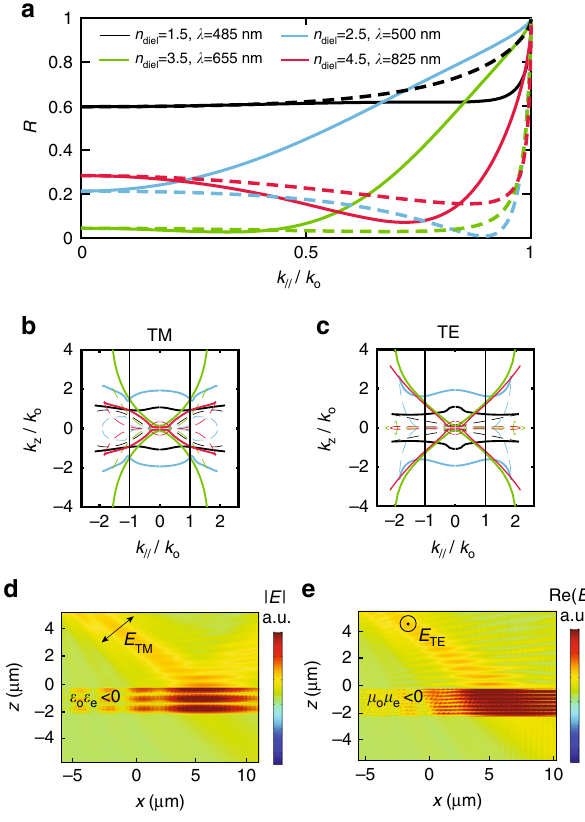
Fig. 4 Bulk propagating modes in magnetic hyperbolic layered metamaterials. Analytical calculations of a re fl ectance and b , c isofrequency diagrams for a metamaterial consisting of fi ve alternating layers of dielectric n diel : 55 nm/Ag: 25 nm. Solid lines in a correspond to TE polarization whereas dashed lines correspond to TM polarization. Solid lines in b , c correspond to real parts, whereas dashed lines correspond to imaginary parts. Vertical black lines in b , c indicate the maximum free space in-plane wavenumber k // = k o . Color code is the same for a – c . d , e Numerical simulation of a fi fty- fi ve layers dielectric ( n diel = 4)/Ag multilayer metamaterial. The surrounding medium has index n sur = 1.55, allowing coupling of high- k modes. We increased the number of layers for clear visibility of fi eld localization inside the structure. Strong fi eld localization is the consequence of d dielectric hyperbolic dispersion for TM polarization ( ϵ o ϵ e < 0) and e magnetic hyperbolic dispersion for TE polarization ( μ o μ e <